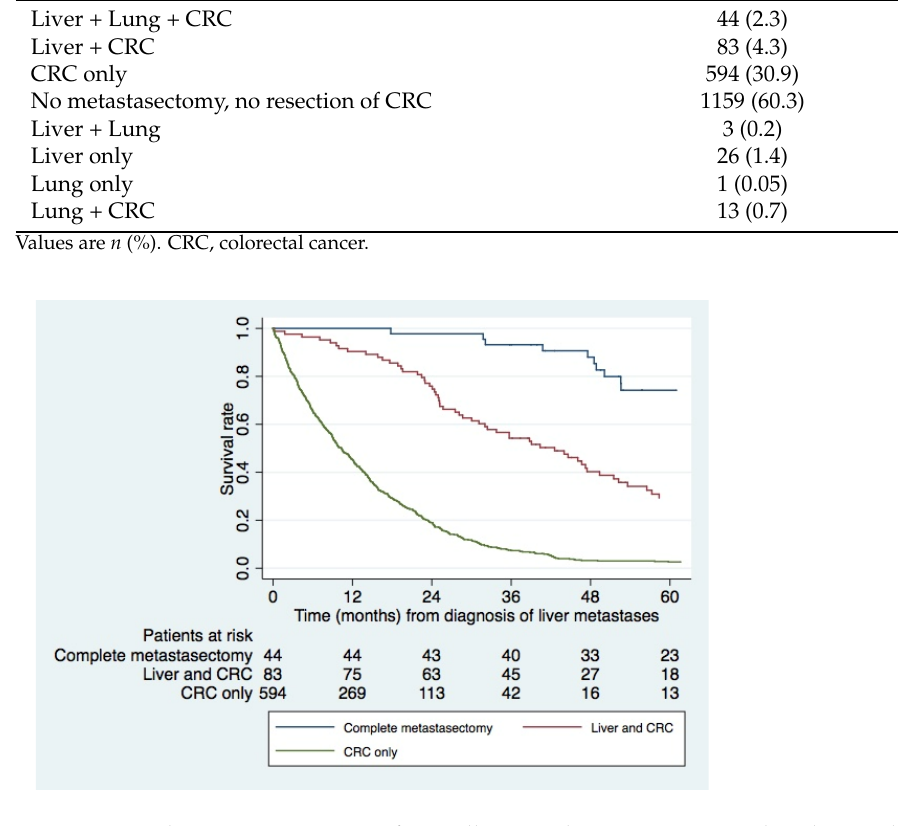
Figure 2. Kaplan–Meier estimates of overall survival in patients treated with complete metastasectomy versus liver resection only versus resection of primary only. Complete metastasectomy including resection of the primary tumor resulted in a 5-year overall survival (OS) of 74.2% (95% CI 57.2–85.3%), while patients having resection of liver metastases and primary tumor had a corresponding estimated median and 5-year OS of 43 months (95% CI 31–49 months) and 29.3% (95% CI 19.2–40.0%), respectively. Resection of the primary tumor only resulted in a median survival of 10 months (95% CI 9–12 months) and a 5-year OS of 2.6% (95% CI 1.5–4.2%). There was a significant survival difference between complete metastasectomy and resection of liver metastases only, log rank test p < 0.001 and between the latter and resection of the primary only (no metastasectomy), log-rank test p < 0.001. CRC, colorectal